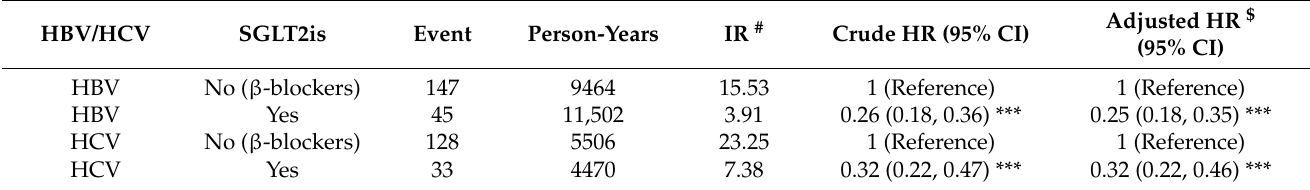
Table 4. Risk of HCC associated with SGLT2is or β -blockers among DM patients stratified by